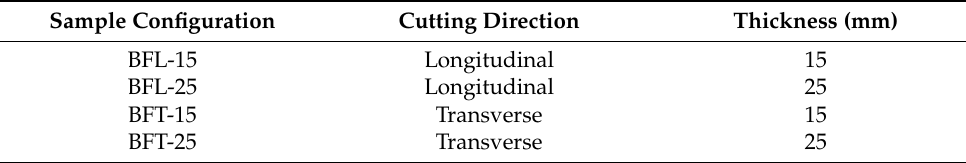
Table 2. Configurations of Buriti foam